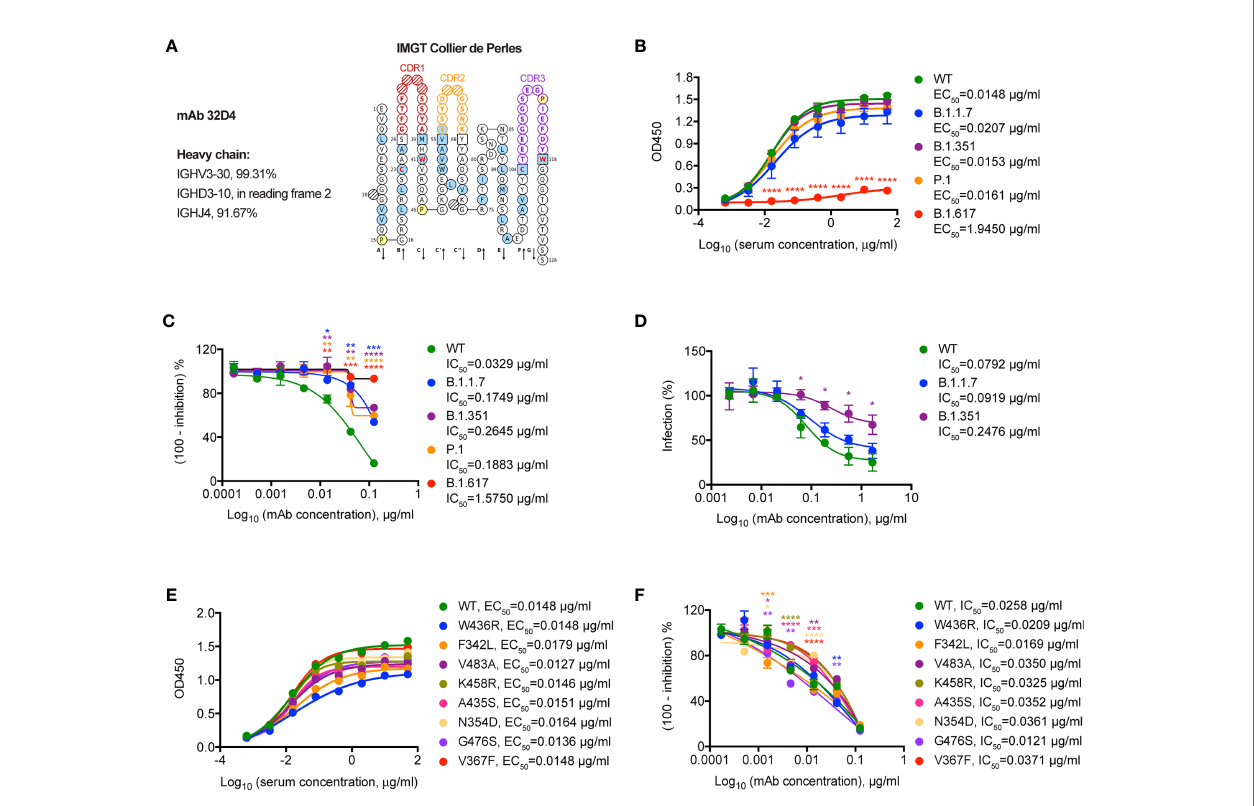
FIGURE 3 | Neutralization of SARS-CoV-2 variants by a VH3-30 mAb 32D4. (A) IMGT Collier de Perles for 32D4. (B) ELISA binding assay of mAb 32D4 to RBD proteins of WT and VOCs. EC 50 , concentration for 50% of maximal effect. (C) ELISA analysis of mAb 32D4-mediated inhibition of WT and VOC RBD proteins binding to ACE2 protein. IC 50 , half maximal inhibitory concentration. (D) 32D4-mediated neutralization of indicated SARS-CoV-2 pseudoviruses. IC 50 , half maximal inhibitory concentration. (E) ELISA binding assay of mAb 32D4 to RBD proteins of WT and non-VOC variants. EC 50 , concentration for 50% of maximal effect. (F) ELISA analysis of mAb 32D4-mediated inhibition of WT and non-VOC RBD proteins binding to ACE2 protein. IC 50 , half maximal inhibitory concentration. * p < 0.05, ** p < 0.01, *** p < 0.001, and **** p < 0.0001. The data are representative of at least two independent experiments. Error bars in (B – D, F) indicate